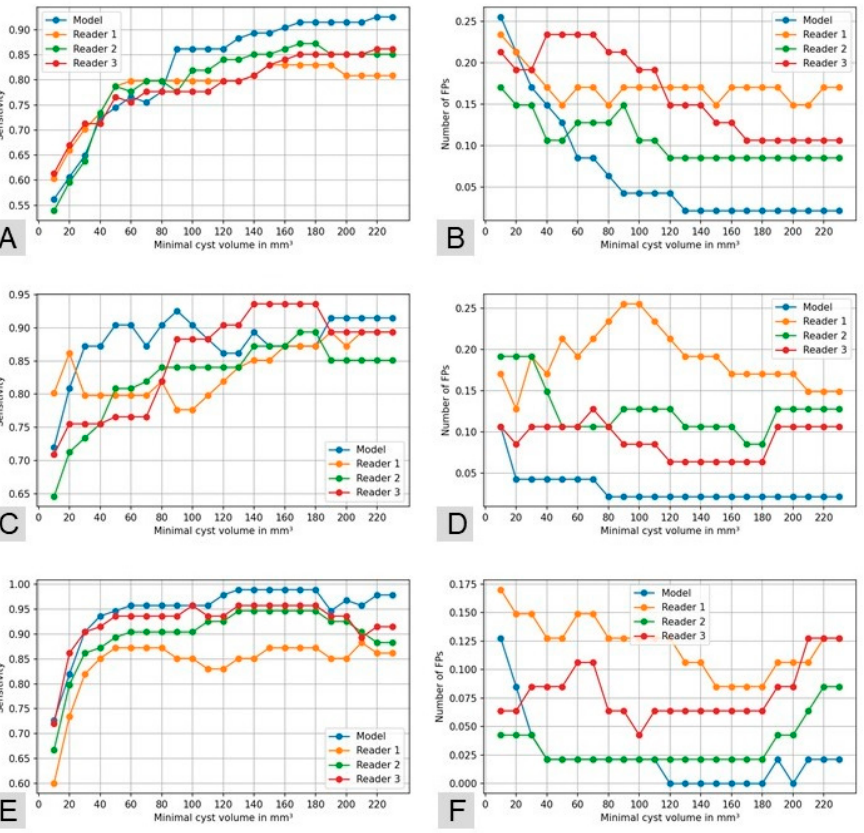
Figure A1. Comparison of each reader with the model’s predictions for each of the three pancreas regions: ( A , B ) proximal; ( C , D ) middle; ( E , F ) distal.